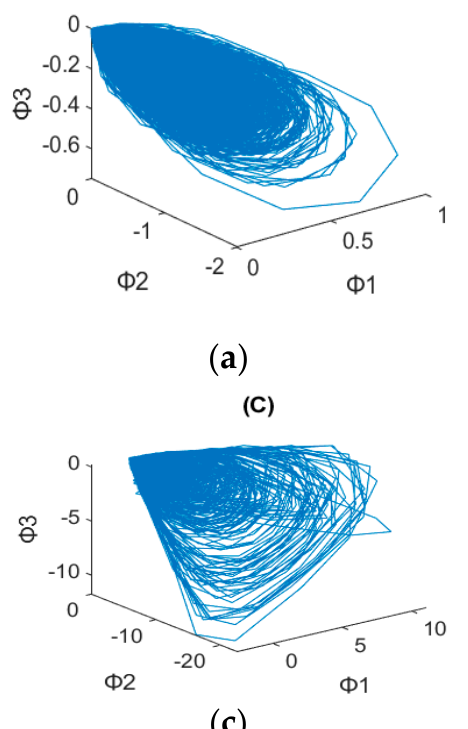
Figure 4. 3D dynamic error phase diagram of a ball bearing under testing, with α = 0.3, HP = 0, and SPOF diameter = 0.007 in. ( a ) Normal state. ( b ) Ball fault. ( c ) Inner race fault. ( d ) Outer race fault.